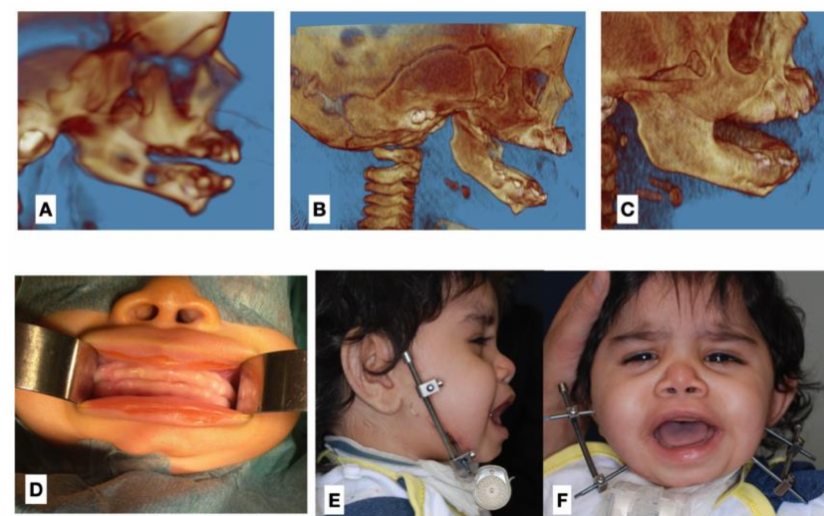
Figure 3. Representative photographs of a 2-year-old patient with bilateral TMJA. ( A ) 3D CT re- construction of the zygomatico-coronoid ankylotic block diagnosed in infancy, ( B ) 3D CT scan reconstruction after early RAS performed at the neonatal age, ( C ) 3D CT scan reconstruction with visi- ble recurrence at the age of 5 months, ( D ) intraoral photograph before treatment showing significantly decreased MIO, ( E ) lateral view during mandible osseodistraction performed as stage 3 surgery (after second RAS), ( F ) frontal view during osseodistraction showing improvement of the MIO.